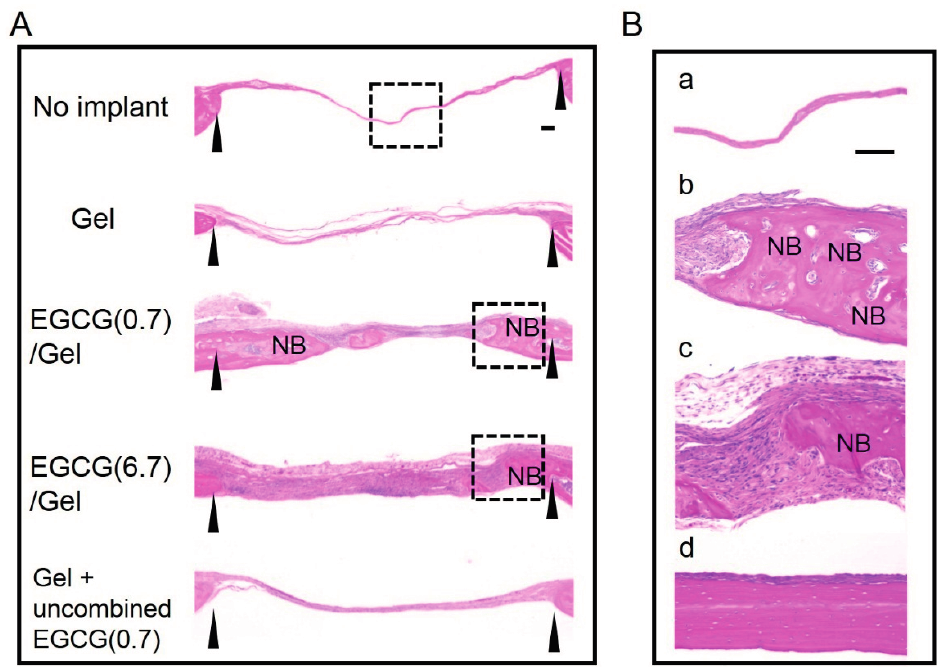
Figure 5. Images of the sections at four weeks after hematoxylin and eosin staining. ( A ) Overview image. Interval of arrowheads: the critical size defect in a mouse calvaria. NB: newly formed bone. Dashed line square: magnified area; and ( B ) Magnified images. ( a ) No implant; ( b ) EGCG (0.7)/Gel; ( c ) EGCG(6.7)/Gel and ( d ) intact bone of the calvaria without any treatment. Bars: 100 μ